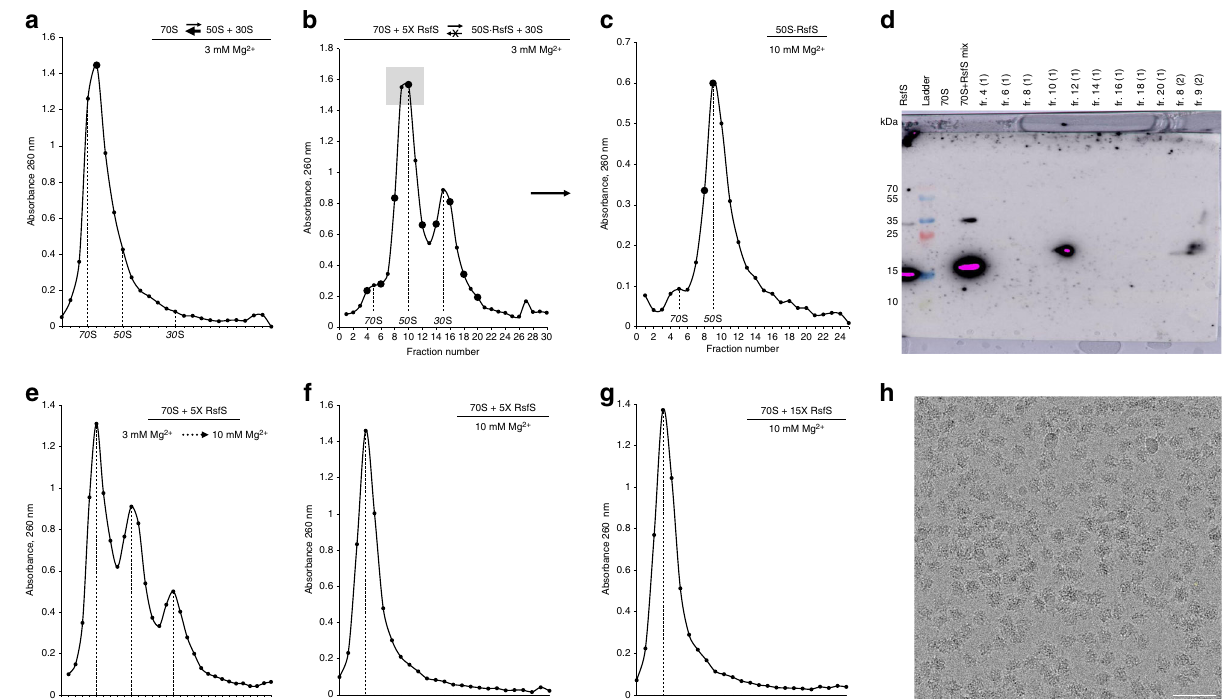
Fig. 1 RsfS protein binds to the 50S particles and prevents ribosomal subunits association. a Sucrose gradient (SG) pro fi le of the 70S at semi- dissociation conditions (3 mM Mg 2 + ) with the equilibrium shifted toward the association. Bold marker indicates the fraction “ 70S ” taken for the western blot analysis. b , c Puri fi cation of the 50S – RsfS complex for cryo-EM studies. SG pro fi le of the 70S at 3 mM Mg 2 + upon addition of 5X excess of RsfS ( b ), and subsequent centrifugation of the complex at 10 mM Mg 2 + ( c ). The gray square indicates the fractions pooled for puri fi cation. Bold markers indicate the fractions taken for the western blot analysis. The peak of the 50S – RsfS complex ( c ) was taken for cryo-EM grid preparation and MS analysis. d Western blot analysis of the selected fractions. e SG pro fi le of 70S + RsfS mixture that was incubated at 3 mM and spun at 10 mM Mg 2 + . f – g SG pro fi les of the 70S mixed 5× ( f ) or 15× ( g ) molar excess of RsfS, incubated and spun at 10 mM Mg 2 + . h Typical electron micrograph of the 50S – RsfS sample. Scale bar represents 50 nm. Source data for panels a – c and e – g are provided as a Source Data fi